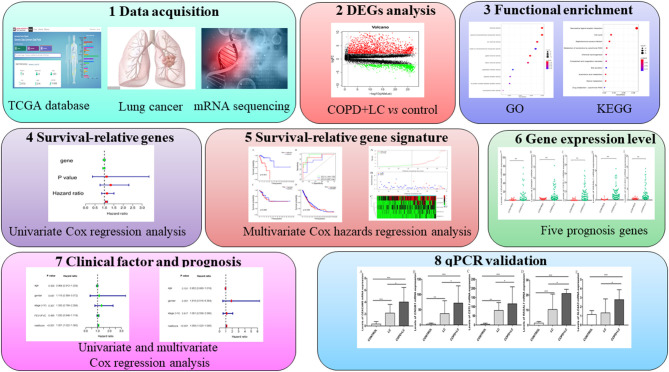
Study flow chart and main findings. *P < 0.05; **P < 0.01; ***P < 0.001.